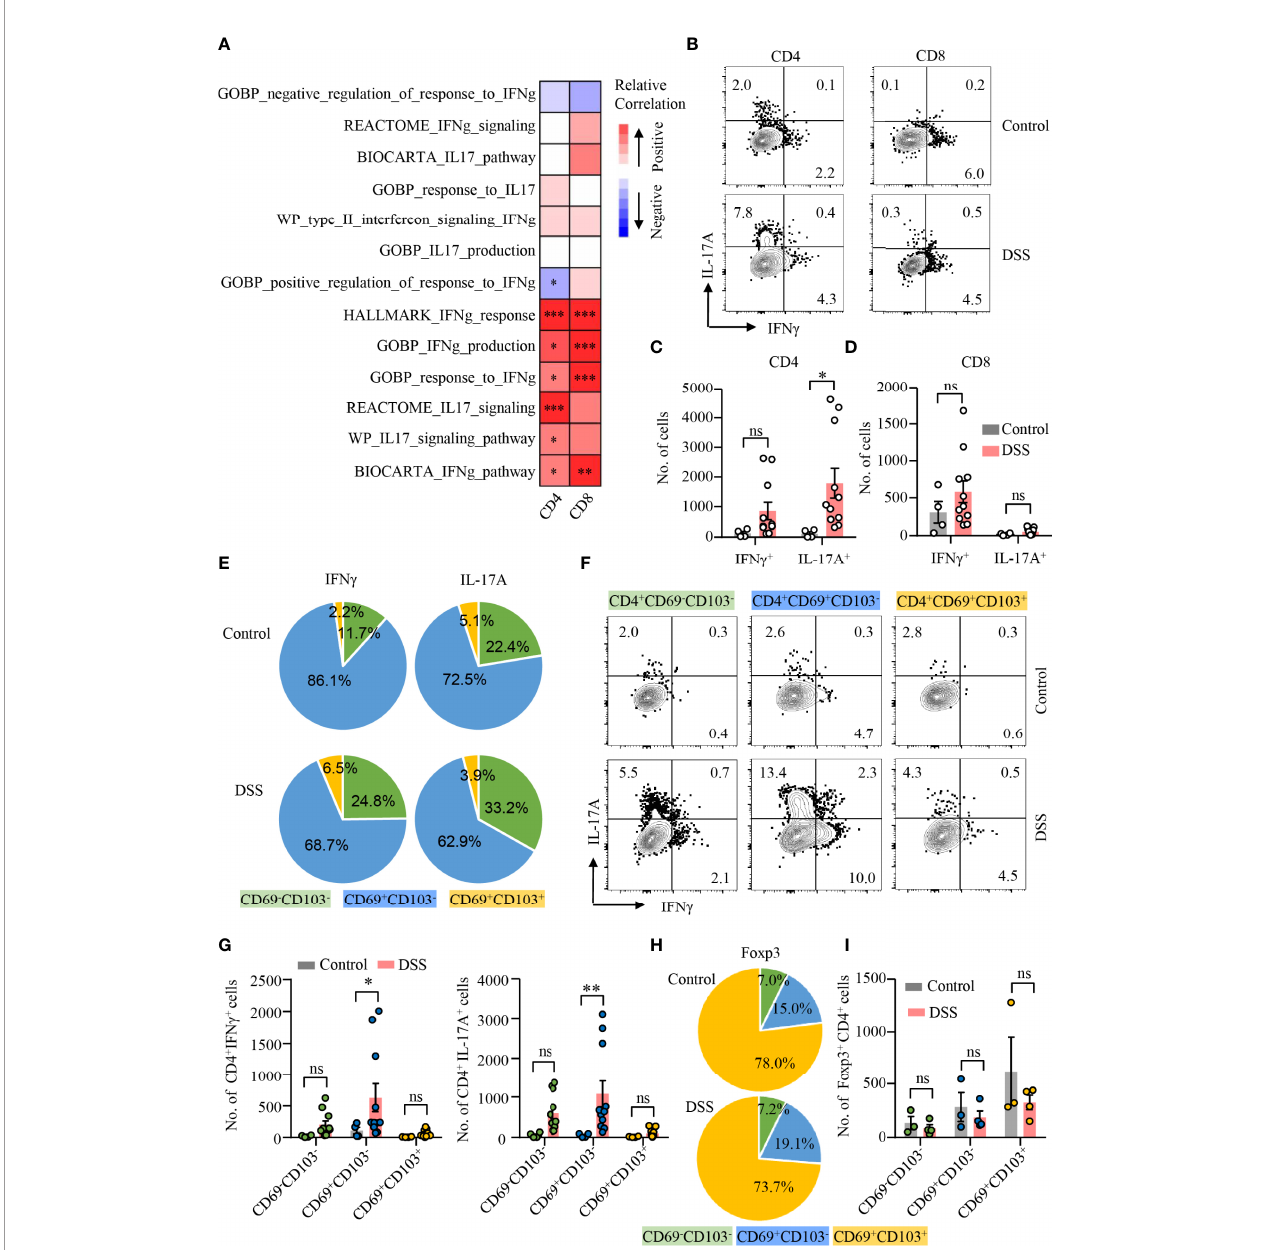
FIGURE 2 | CD4 + CD69 + CD103 − T RM cells as the major source of IL-17A production during DSS-induced colitis. (A) scRNA-seq data derived from GSE148794 were used for analysis. CD4 + and CD8 + T cells were identi fi ed and further adopted to calculate GSVA score. Heatmap showing correlation between T RM signature score of CD4 + /CD8 + T-cell population and ES of indicated gene sets using the Spearman ’ s correlation analysis. IL-17 and IFN g signaling pathway gene sets were derived from MSigDB. (B – I) DSS-induced colitis was established as described in Figure 1 . Colons were collected from mice with or without DSS-induced colitis. LPMCs were isolated and intracellular cytokine staining of IFN g and IL-17A in CD4 + and CD8 + T cells was performed and measured by fl ow cytometry. (B) Representative counter plots of IFN g and IL-17A expression in CD4 + T cells and CD8 + T cells from mice with or without DSS-induced colitis. (C) Numbers of IFN g + and IL-17A + CD4 + T cells. (D) Numbers of IFN g + and IL-17A + CD8 + T cell. (E) Distribution of IFN g + and IL-17A + cells among CD4 + CD69 − CD103 − , CD4 + CD69 + CD103 − , and CD4 + CD69 + CD103 + subsets from mice with or without DSS-induced colitis. (F) Representative counter plots of IFN g and IL-17A expression in CD4 + CD69 − CD103 − , CD4 + CD69 + CD103 − , or CD4 + CD69 + CD103 + subsets. (G) Numbers of IFN g + and IL-17A + CD4 + T cells in mice with DSS-induced colitis to control mice. (H) FoxP3 expression in CD4 + T cells was measured by fl ow cytometry. Distribution of CD4 + CD69 − CD103 − , CD4 + CD69 + CD103 − , and CD4 + CD69 + CD103 + subsets in FoxP3 + cells from mice with or without DSS-induced colitis was shown. (I) Numbers of FoxP3 + CD4 + T cells in mice with DSS-induced colitis and control mice were summarized. Each dot represents an independent mouse sample. Data are means ± SEM. * p < 0.05, ** p < 0.01, *** p < 0.001 by Student ’ s t -test. ns, not signi fi